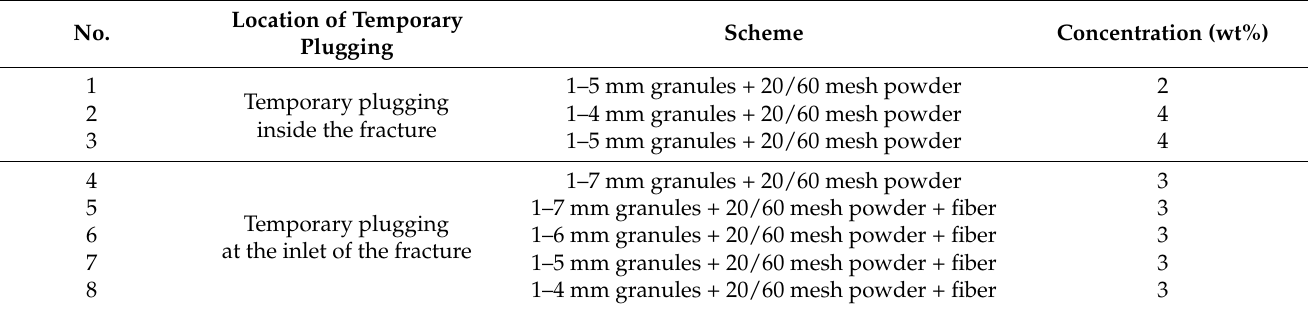
Table 1. Experimental scheme for evaluation of the diversion